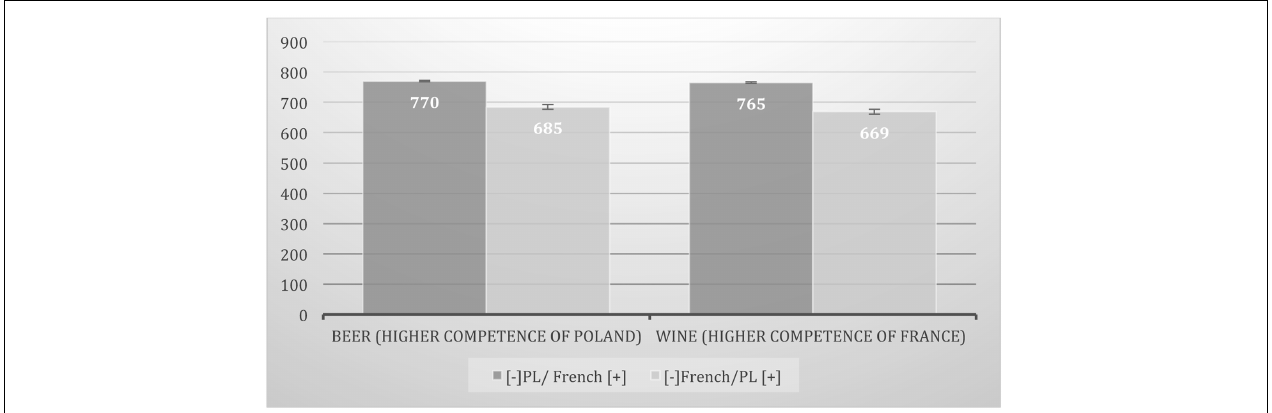
FIGURE 3 | Comparison of ICE toward Polish (Polish) vs. French (foreign) non-existent brands (IAT effect) in two product categories of different level of competence: (a) beer – higher competence of Poland and (b) wine – higher competence of France. Categorization time in milliseconds (ms).